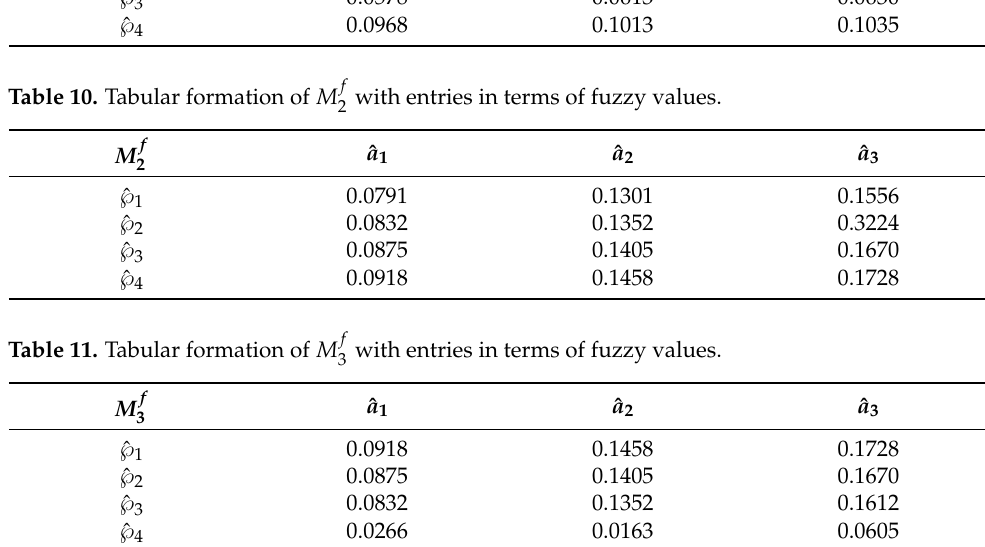
Table 10. Tabular formation of M f